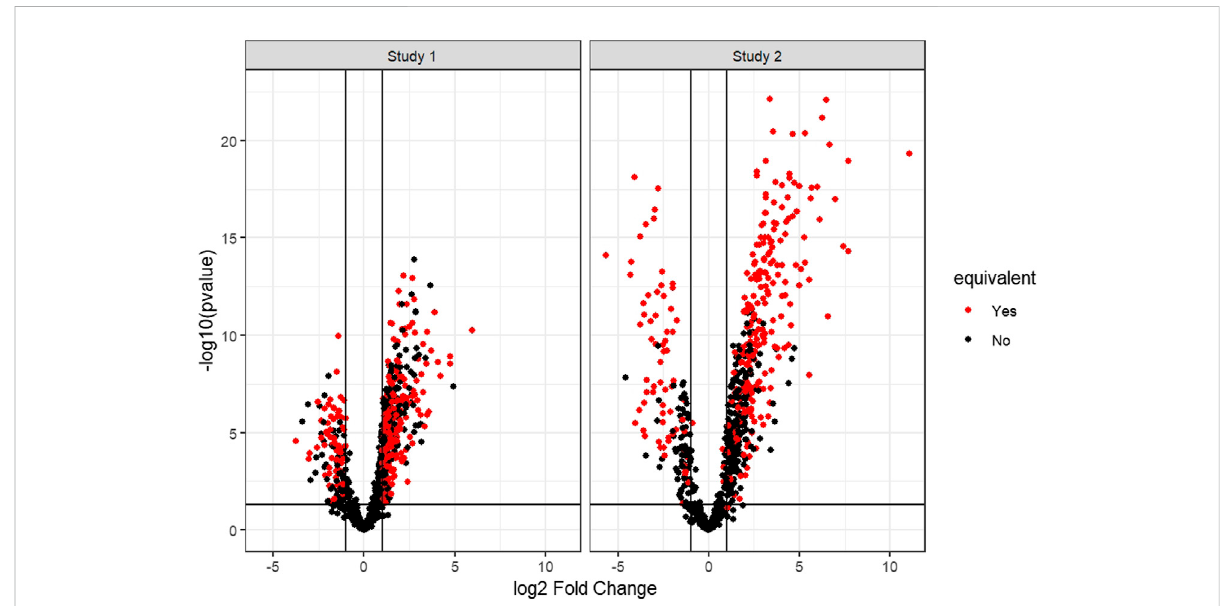
FIGURE 2 Example volcano plots of the two simulated gene expression studies of one simulation iteration. Marked red are all genes set to be equivalent betweenthetwostudies.Here,thedifferentialexpressionofthegenestobesetequivalentlychangedbetweenthetwosimulatedstudiesmustpassa